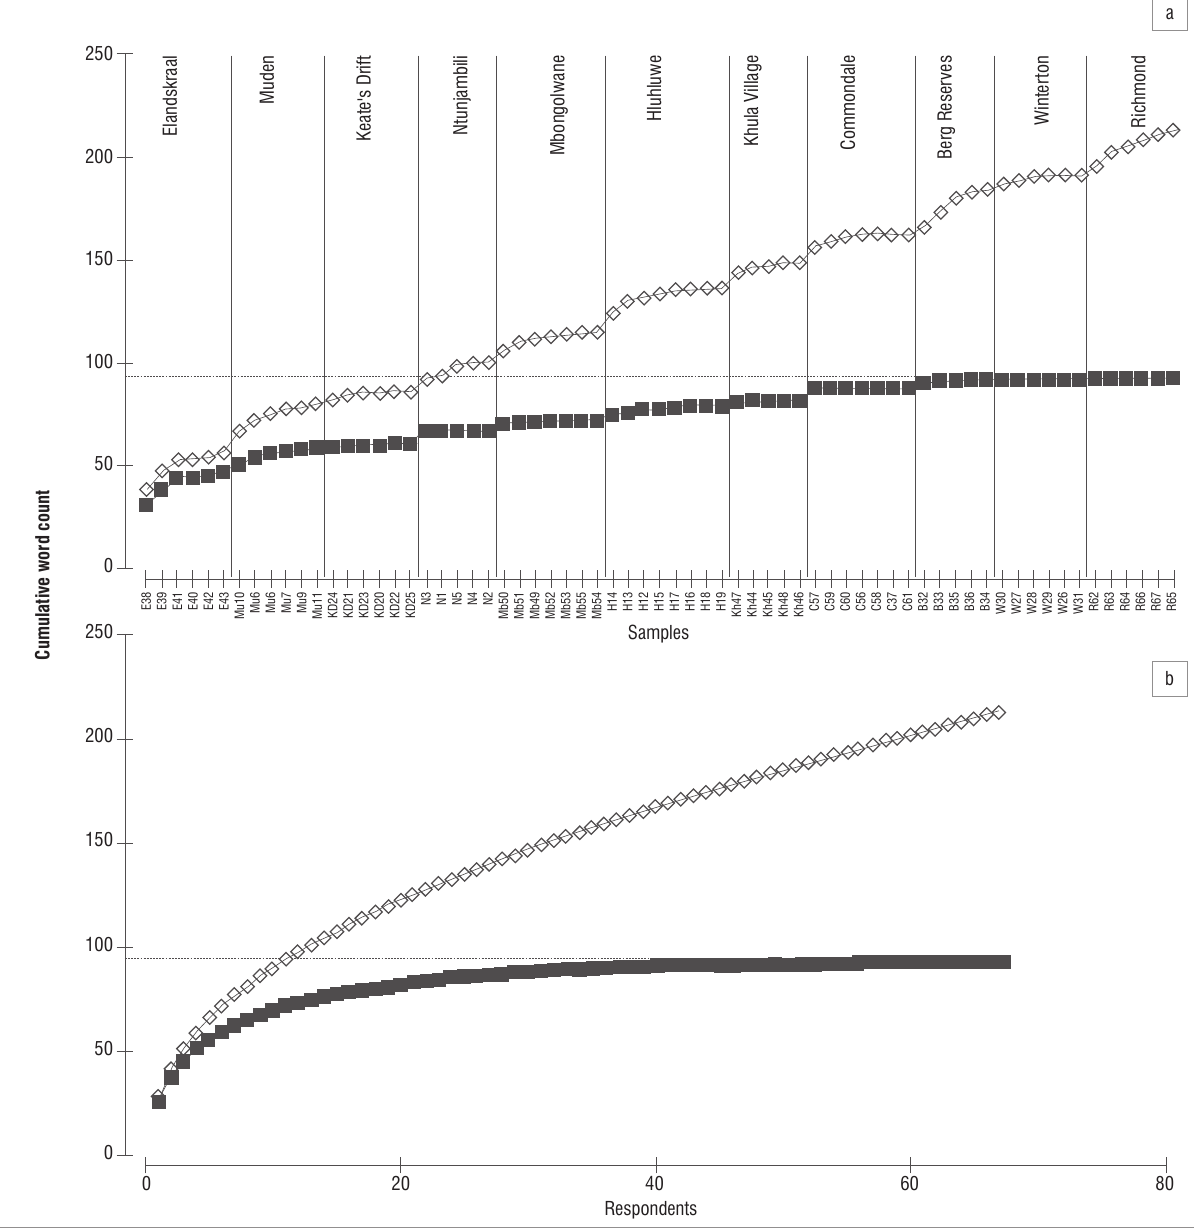
Figure 3: (a) Sample-accumulation curves constructed without permutation of samples. The flattening of the curves within each locality indicates that they are adequately surveyed. (b) Sample-accumulation curves constructed using 999 sampling permutations, used to estimate how many isiZulu entomological names there may be. The sample of non-personal names (i.e. those reported by at least two respondents from different sites; solid symbols) reaches an apparent asymptote at 93 names (dotted line), while the sample is still growing when personal names (i.e. names reported by only one respondent) are